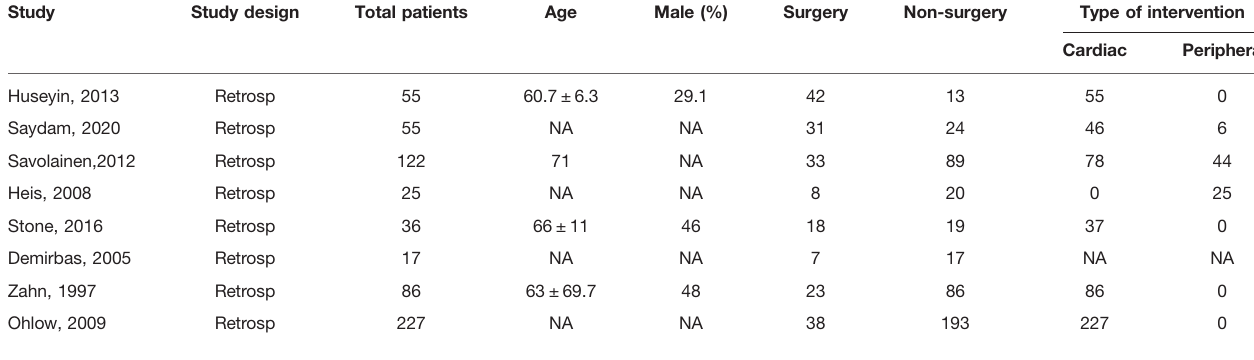
TABLE 1 | Overall characteristics of the studies.